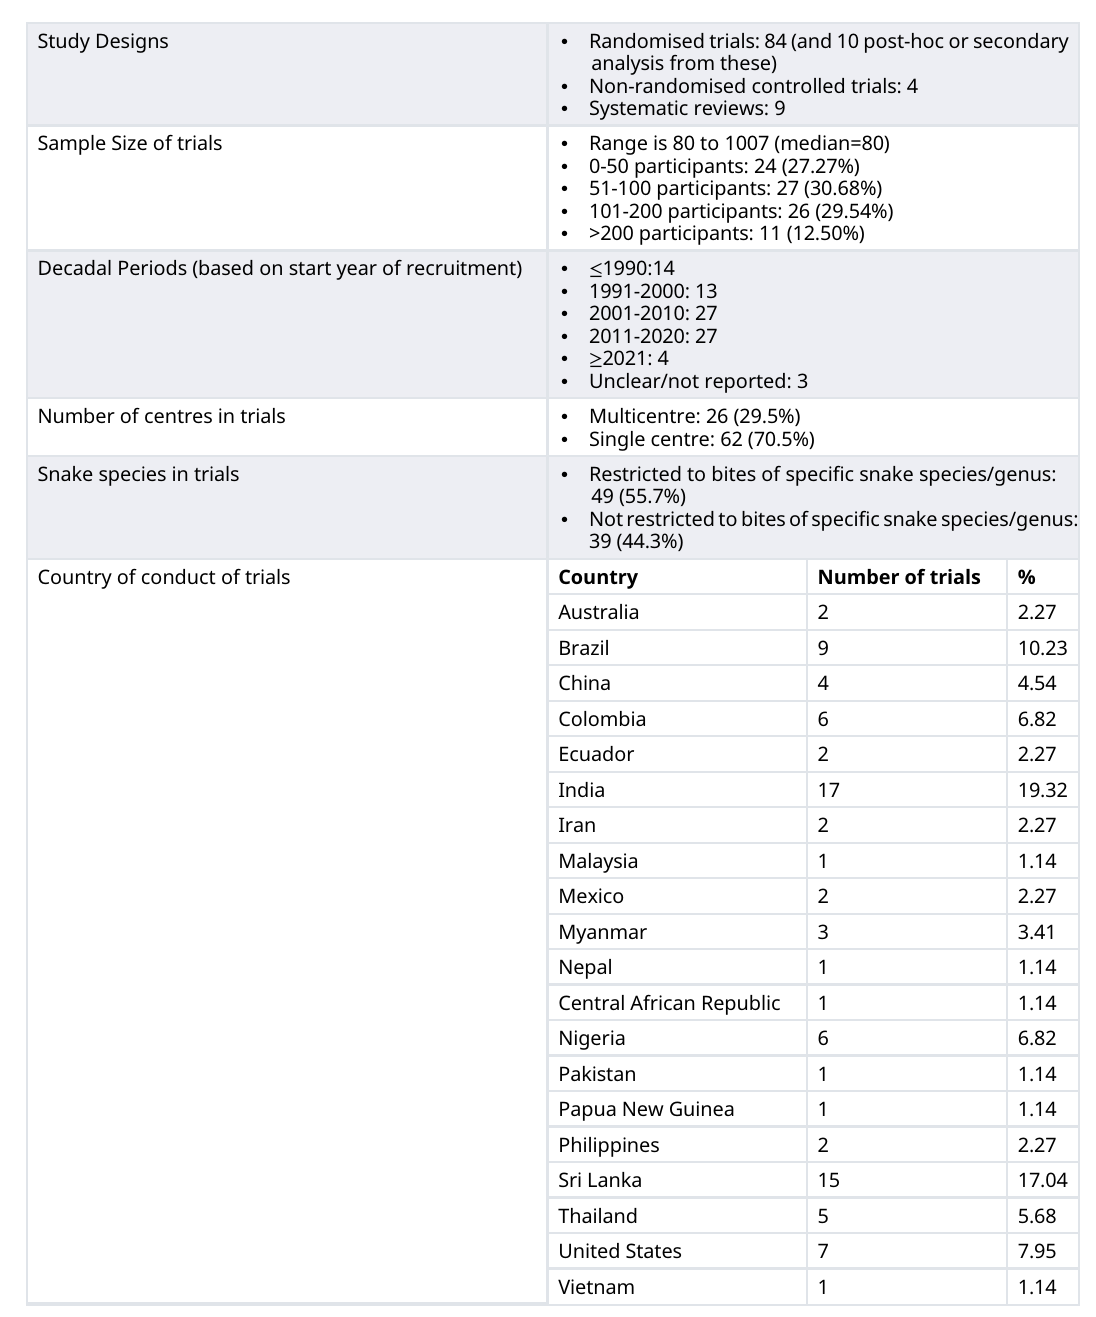
reported resource use outcomes. The focus of trials from South America, Southeast Asia and the rest of Asia is overwhelmingly in physiological/clinical outcomes. Blood and lymphatic system outcomes were proportionately much higher in African trials (64.00%) compared to South Asian (35.63%) trials. South Asian trials measured renal outcomes more (in 18.39% trials) compared to trials in other regions. Reporting of respiratory outcomes were uncommon except in Australia and Papua New Guinea (11.11%) trials.